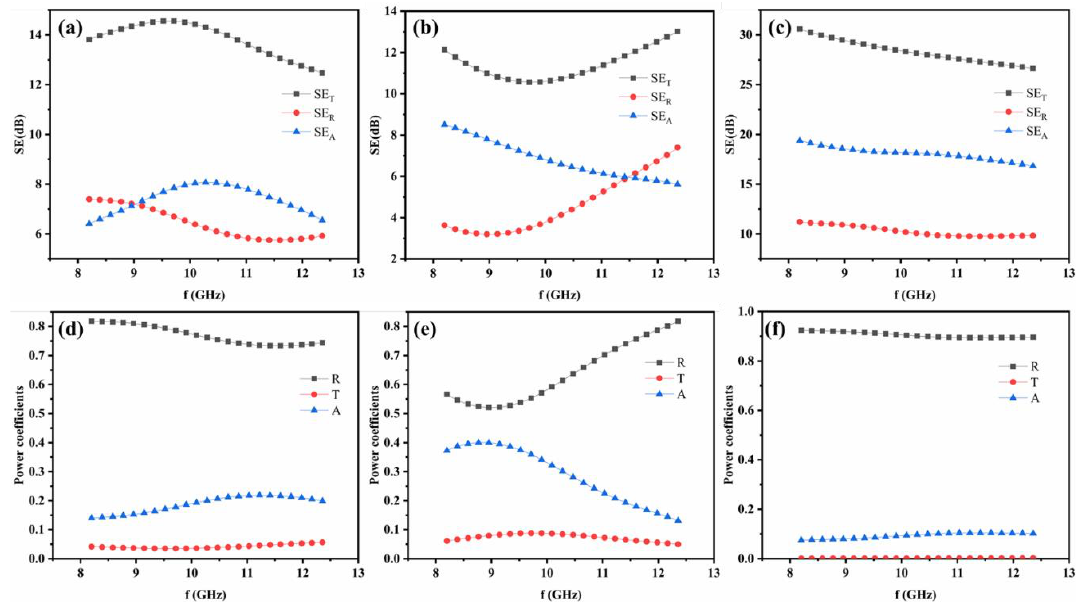
Figure 2. EMI SE and power coefficients R, T, A of ( a , d ) sample 1; ( b , e ) sample 2 and ( c , f ) sample 4 with same structure of 1CF-EP-CNTF/1CF-EP with areal density of 6.8 g/m 2 .